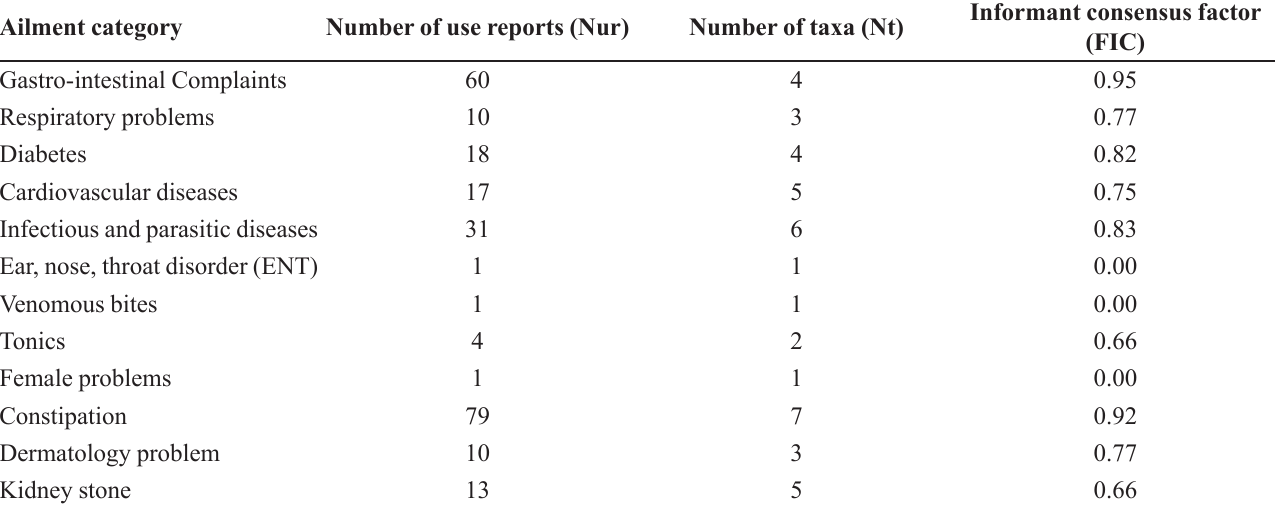
TABLE V - Informant consensus factor (FIC) for categorized